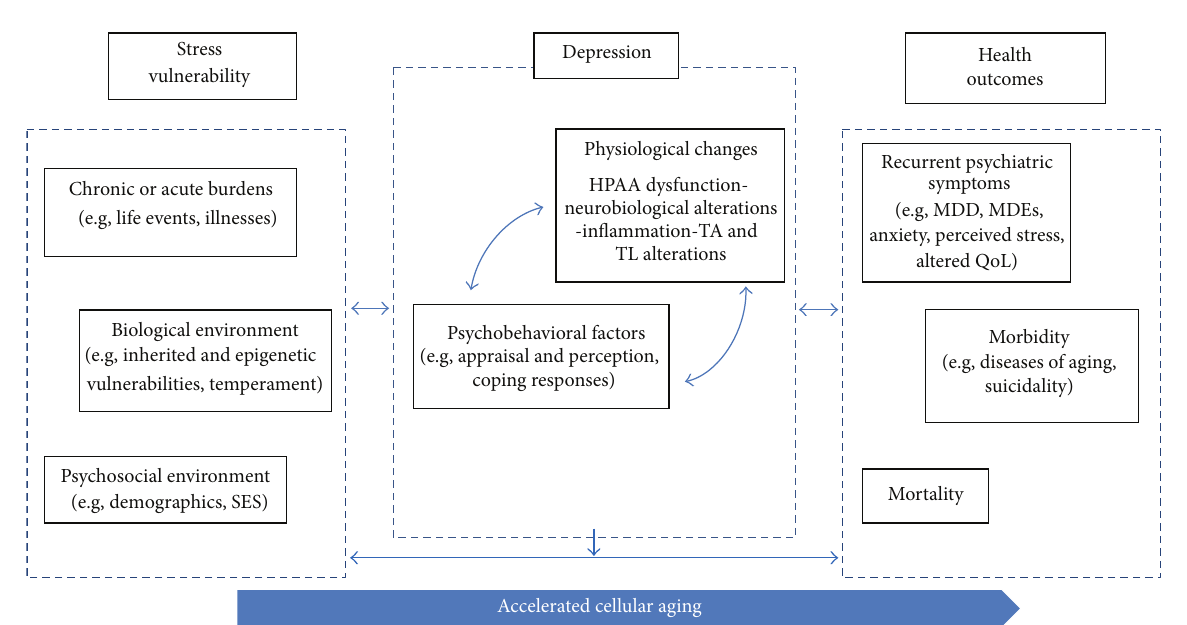
Figure 2: Accelerated cellular aging: stress vulnerability, depression, and health outcomes. SES = socioeconomic status; ECD = early childhood development; HPAA = hypothalamus-pituitary-adrenal axis; TA = telomerase activity; TL = telomere length; MDD = major depressive disorder; MDEs = major depressive episodes; QoL = quality of